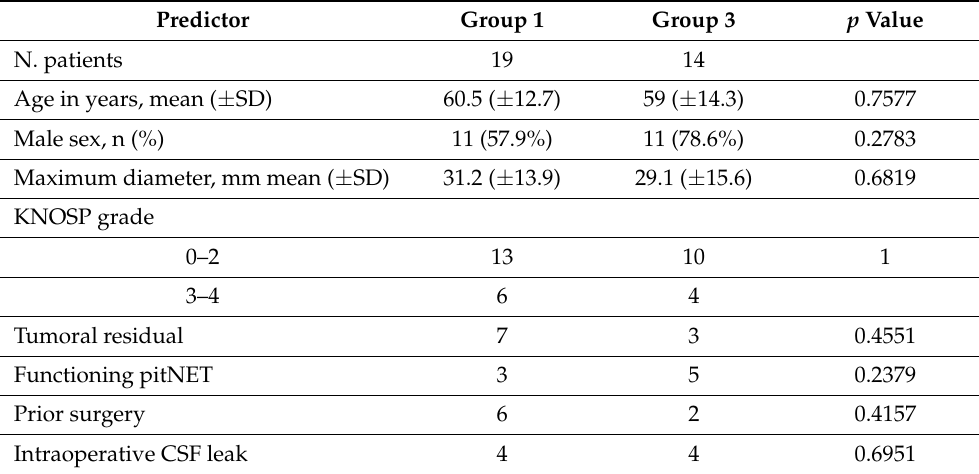
Table 4. Predictors of new pituitary gland deficiency following transsphenoidal